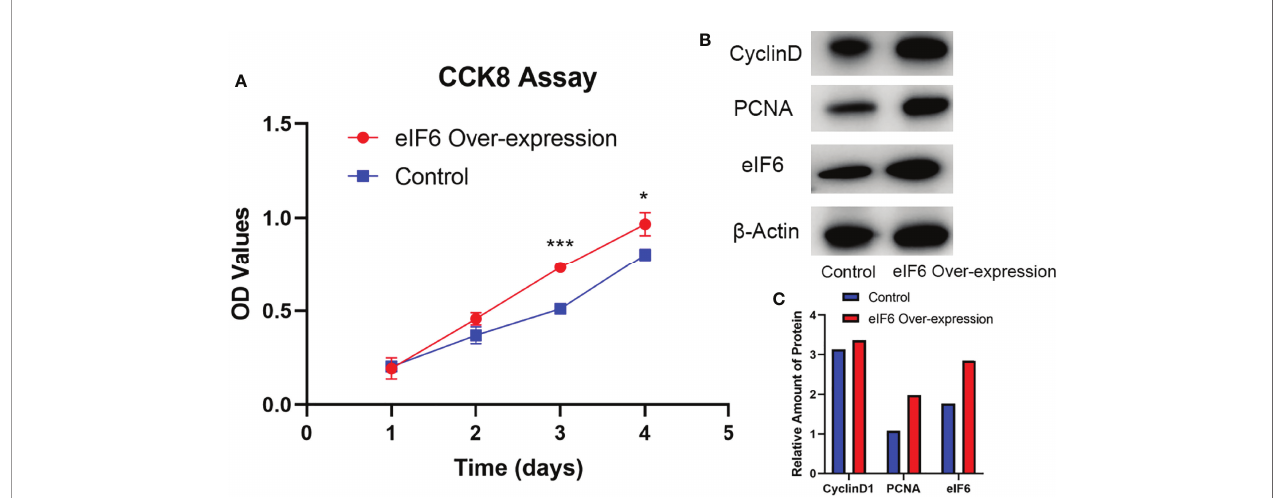
FIGURE 3 | Evaluation of the cellular functions of high-expressed eIF6 in A375 melanoma cells. (A) Growth curves comparison between eIF6-overexpressing and wild type (control) A375 cells. The growth rate of eIF6 overexpressing cells was signi fi cantly higher than controls. (B) Western blot analysis con fi rms the correlation of up-regulated eIF6 with the cell proliferation marker CyclinD1 and PCNA. (C) Quanti fi cation of the Western blot results by Image J. The grey density of the bands was measured by Image J, and the target gene expression level was normalized with the grey density of b -actin. The signi fi cance test of change was evaluated with P value. P value < 0.05 was labeled as “ * ” . P-value < 0.01 was labeled as “ ** ” . P-value < 0.001 was labeled as “ *** ”